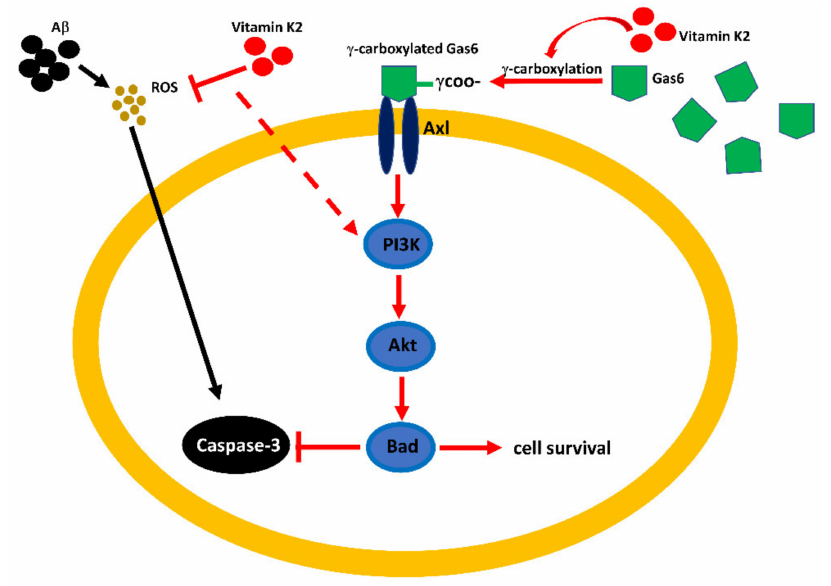
Figure 9. Summary of the possible molecular mechanism and signal pathway involved in vitamin K2 protection against A β -induced cytotoxicity.